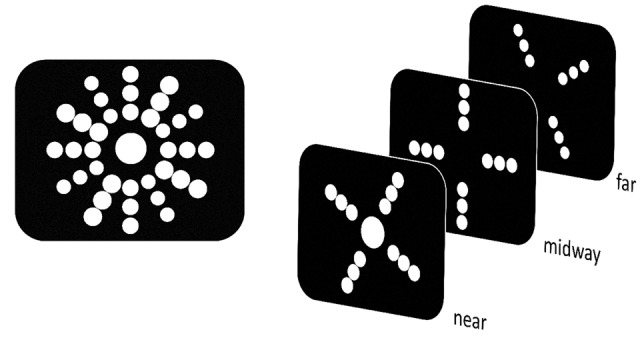
Schematic illustration of the stimulus material used in both experiments. Left part depicts a front view as seen by the participants via head-mounted displays (HMD). Right part portrays the stimulus distribution across depth planes. The central target either appeared in the near or far depth plane. Surrounding spheres were visible throughout the whole experiment in order to create a reference space for the target. Offset between near and far depth plane was altered between Experiments 1 and 2 (see “Materials and Methods”).